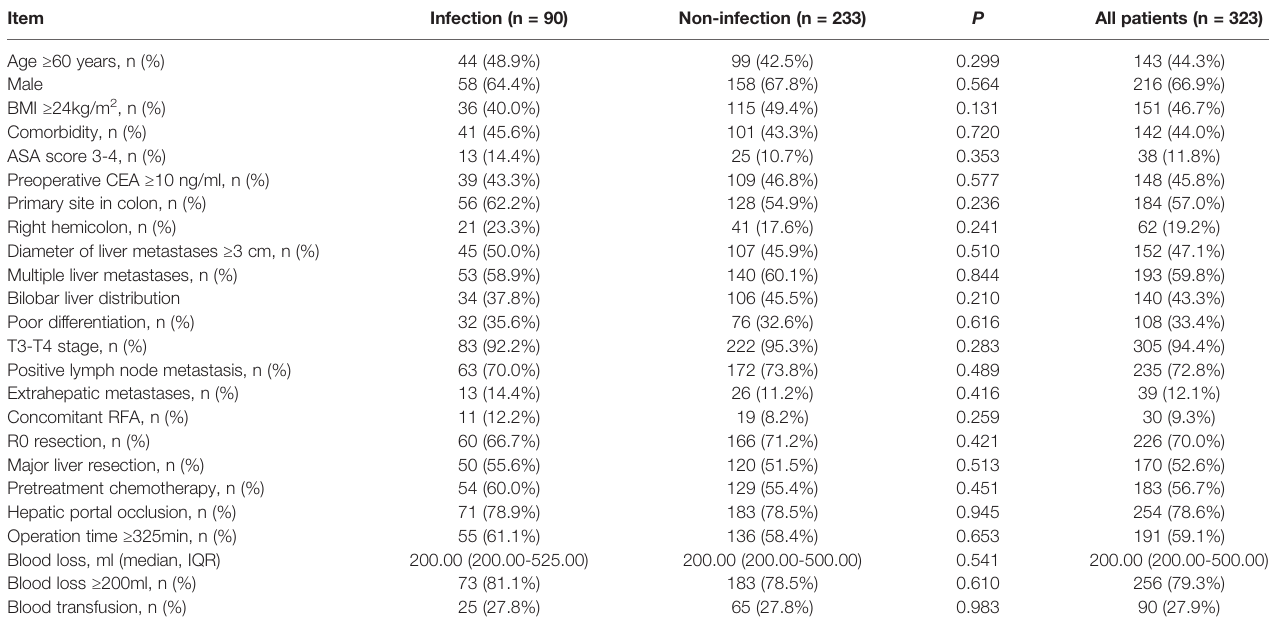
TABLE 2 | Postoperative infectious complications in CRLM patients after PSM